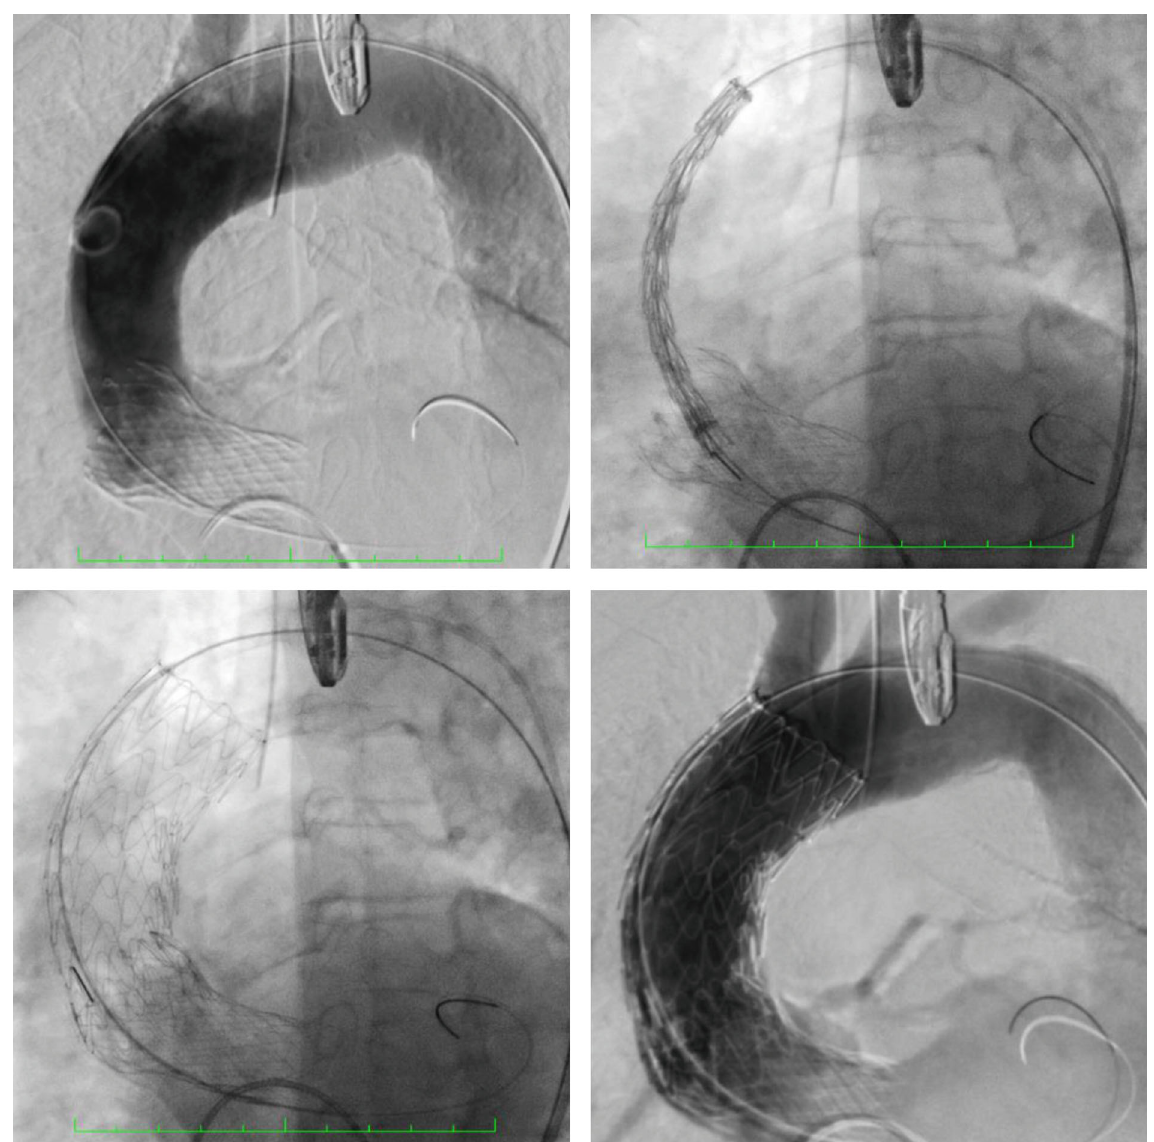
Figure 2: Endograft deployment and fi nal